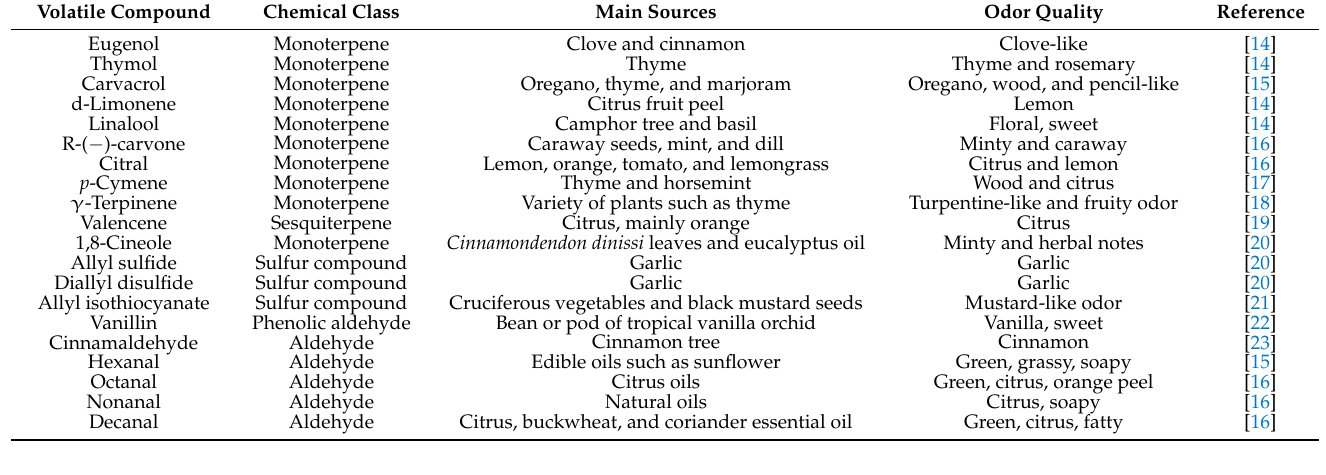
Table 1. Volatile chemical compounds commonly used in food packaging.